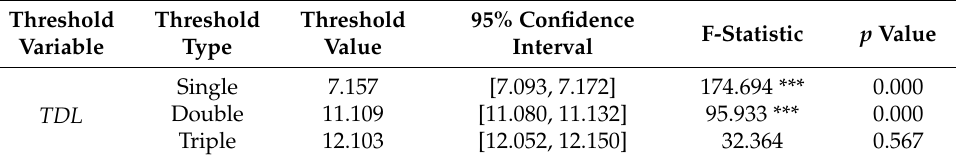
Table 5. Results of threshold value estimation and significance test of the threshold effect.